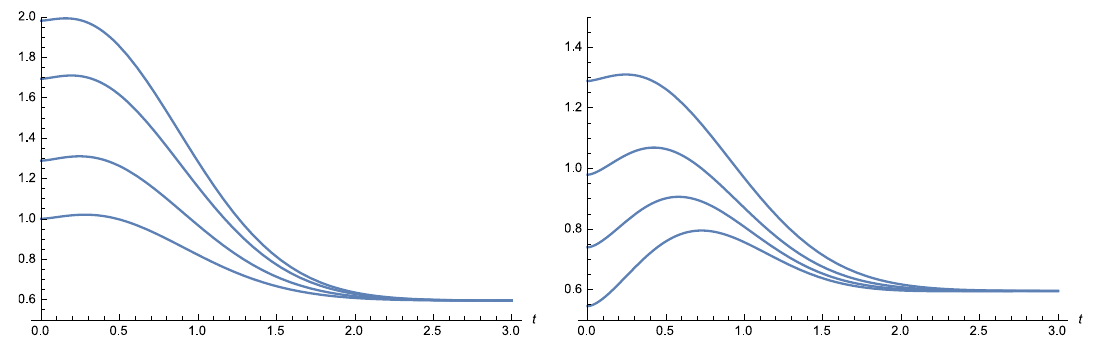
for λ = 1 and k = 2. Left : h = 2 and µ = 1.5, 2, 3, 4 X Y t